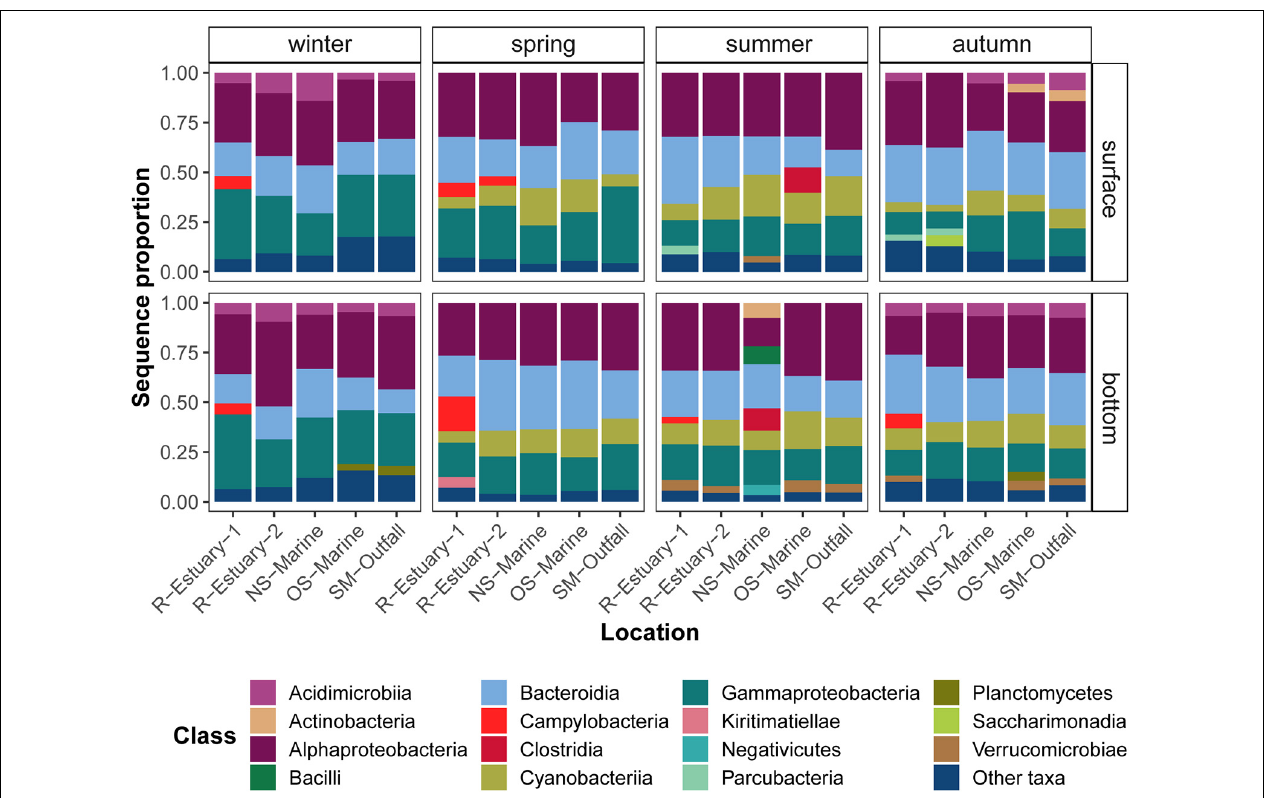
FIGURE 3 | Sequence proportion of dominant bacterial classes at the surface and bottom layer in winter, spring, summer, and autumn during the 2018/2019 survey in the eastern part of the Gulf of Trieste (sampling stations: R-Estuary-1, R-Estuary-2. NS-Marine, OS-Marine and SM-Outfall). Classes showing a sequence proportion of < 3% were grouped together as “other